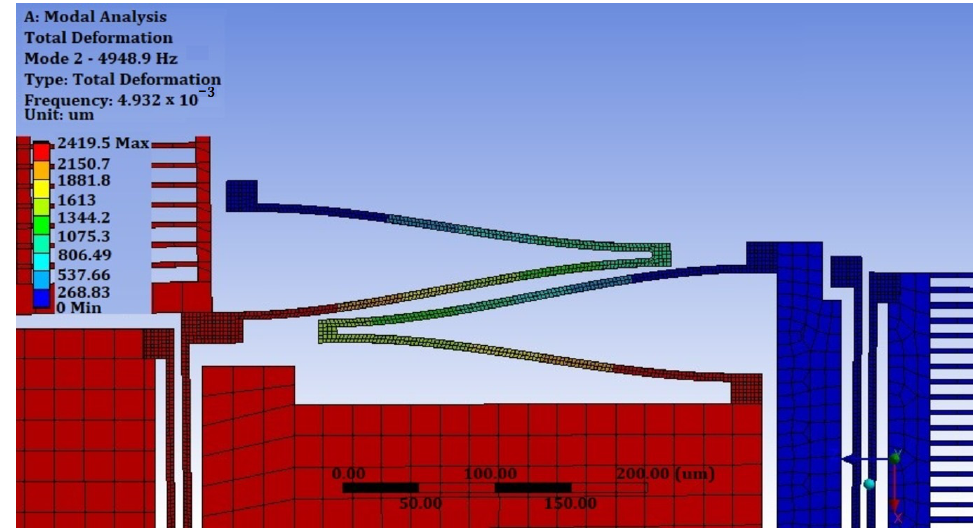
Figure 13. The diagram of deformations of an elastic beam during